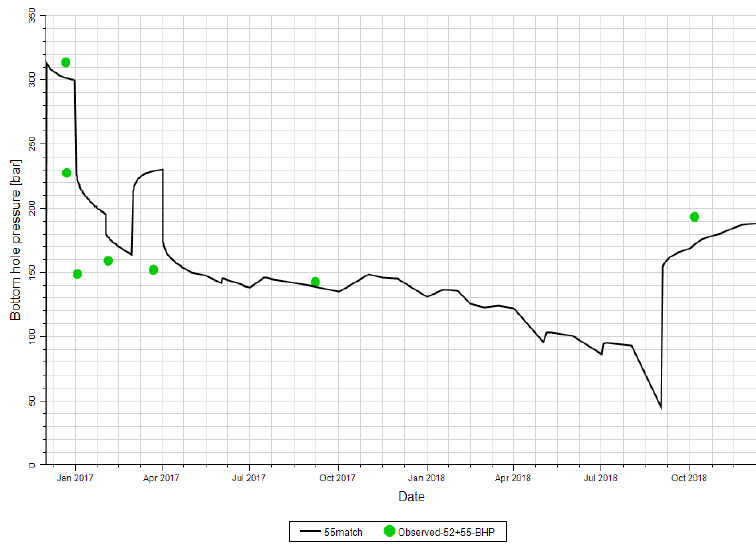
Figure 8. The fitting result of bottom hole flow pressure.